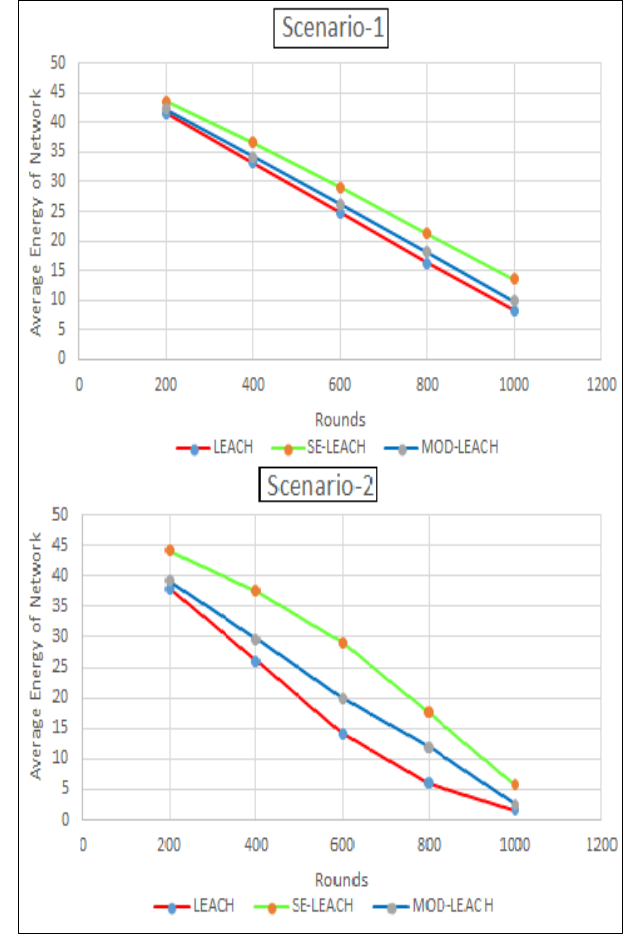
Figure 4. Network’s Average